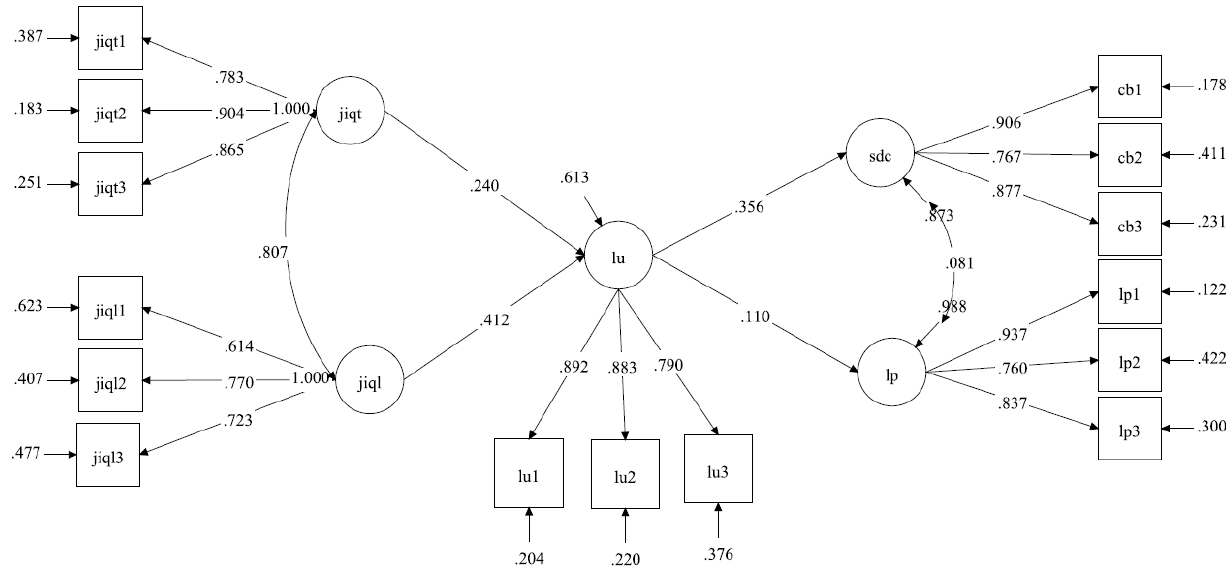
Figure 2. Multivariate Mediation Model with Structural Equation Modeling. Note: Standardized coefficients are reported. All parameters were statistically significant for p < 0.05. Jiqt = quantitative job insecurity; jiql = qualitative job insecurity; lu = life uncertainty; sdc = sacrifice of consumption; lp = unaffordability of life projects. Fit Indexes Chi ‐ square (84) = 227.48, p < 0.01, CFI = 0.98, TLI = 0.98, RMSEA = 0.04, SRMR = 0.03.